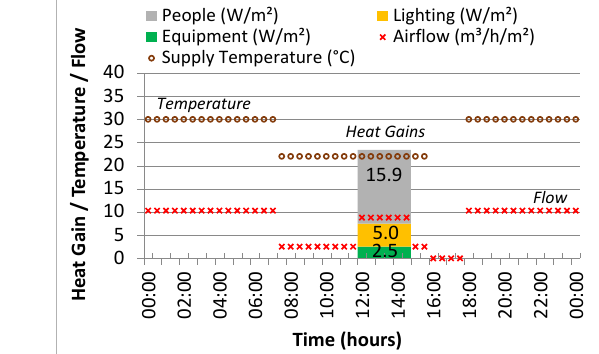
Figure 6. Specific internal heat gains, specific airflows, and supply air temperatures for Scenario I ( left ) and Scenario II ( right ). The measurement setup used in the test room was shown above in Figures 4 and 5.